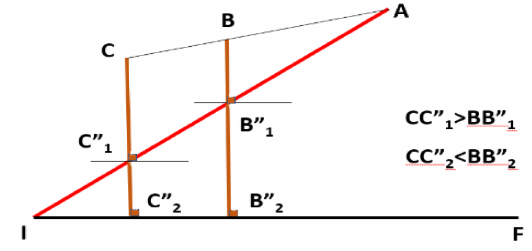
Figure 8. Relative and absolute PIPs through VD prism (source: own